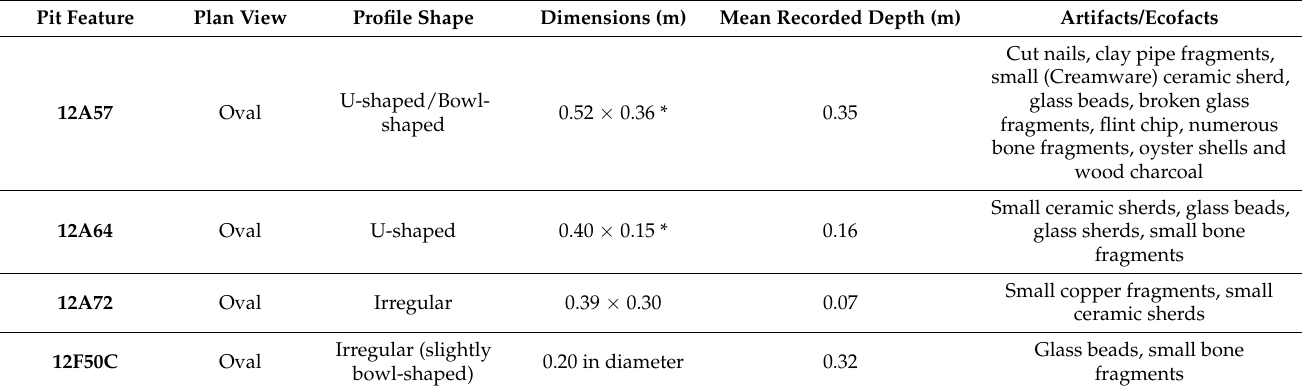
Table 2. Morphology and material content of pit features sampled in areas 12A and 12F of the Fort Odanak site [14].